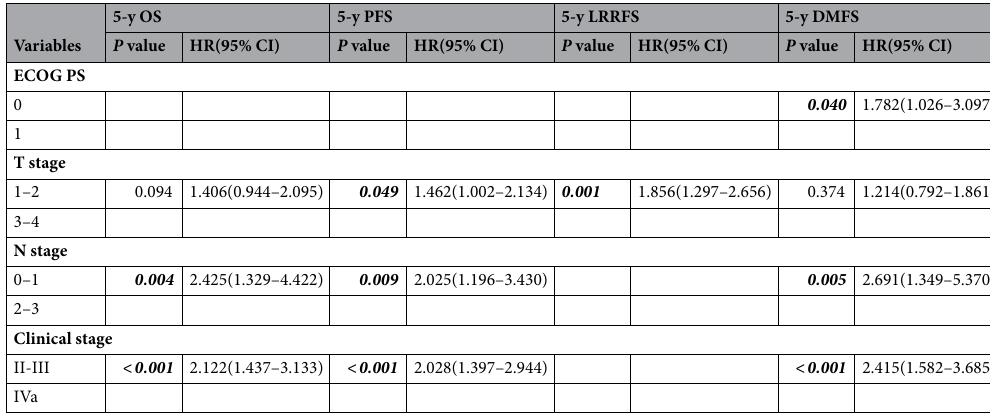
Table 3. Multivariate analysis of factors potentially associated with survival. Significant values are in [bolditalic]. OS overall survival, PFS progression-free survival, LRRFS locoregional relapse-free survival, DMFS distant metastasis-free survival, ECOG PS Eastern Cooperative Oncology Group Performance Status, HR hazard